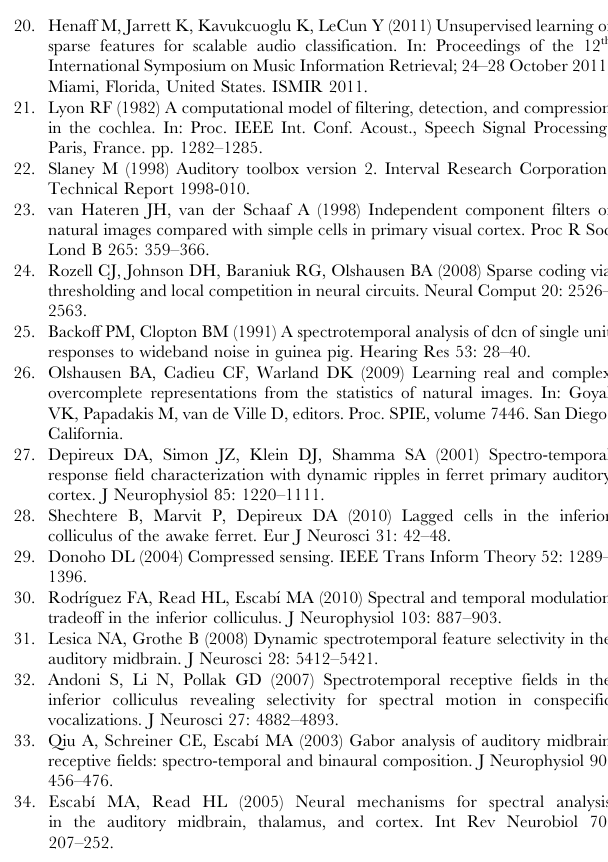
Figure S16 The full set of elements from a two times overcomplete, L1-sparse dictionary trained with LCA [ 24 ] on cochleograms of speech. Same conventions as Fig. S11. (TIF) Figure S17 The full set of elements from a four times overcomplete, L1-sparse dictionary trained with LCA [ 24 ] on cochleograms of speech. Same conventions as Fig. S11. (TIF) Figure S18 The full set of elements from a half- complete, L1-sparse dictionary trained with Sparsenet [ 10 ] on cochleograms of speech. Same conventions as Fig. S11. Figure S19 The full set of elements from a complete, L1-sparse dictionary trained with Sparsenet [ 10 ] on cochleograms of speech. Same conventions as Fig. S11. Figure S20 The signal to noise ratio (SNR) of sparse coding dictionaries increases with overcompleteness and with increasing numbers of active elements. Blue lines with triangles represent L0-sparse dictionaries, whereas green lines represent L1-sparse dictionaries. As expected, representations are more accurate with increasing numbers of active neurons and also when the level of overcompleteness is increased. Interestingly, the L0-sparse dictionaries typically have higher SNRs than the L1- sparse dictionaries. A few other general trends are evident as